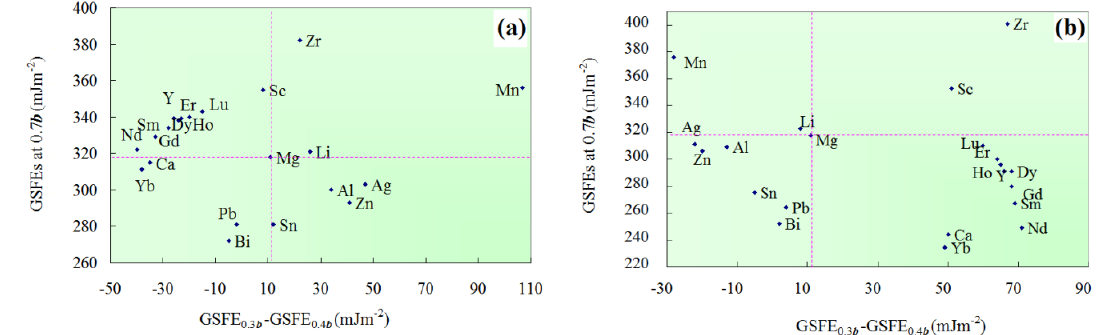
Figure 3. Alloy e ff ects on GSFE0.7 b and GSFE0.3b-GSFE0.4b. ( a ) Slip mode I. ( b ) Slip mode II.